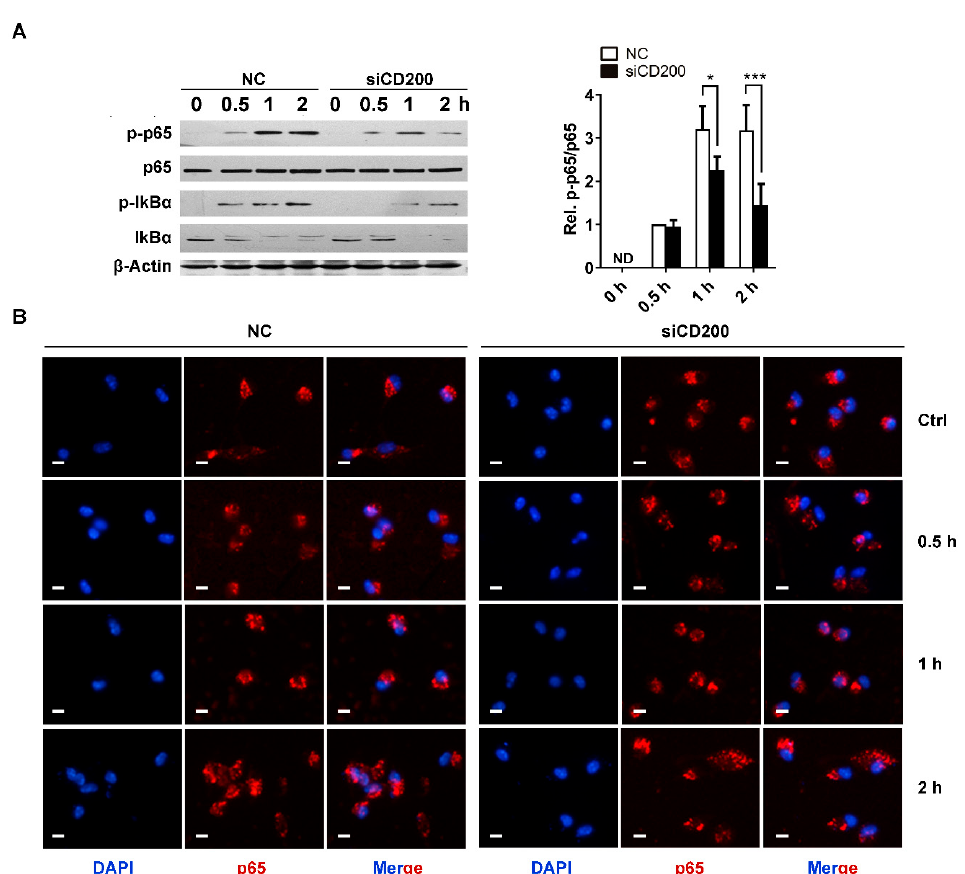
Figure 5. CD200 mildly affects NF- κ B activation triggered by Staphylococcal infection. Mouse PEMs were transfected with CD200 siRNA or NC siRNA for 48 h, and then stimulated with S. aureus (MOI = 1) for indicated time periods (0–2 h). ( A ) Cells were lysed, and the protein level of p-p65, p65, p-I κ B α , or I κ B α was detected by western blotting. β -Actin served as a loading control. ( B )